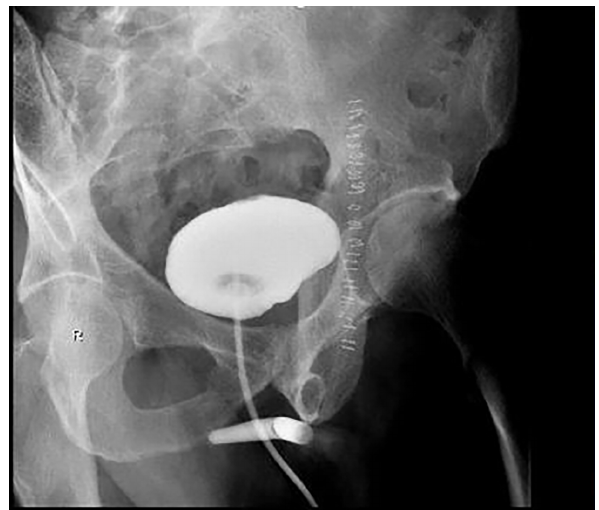
Fig. 3. A pelvic X-ray with contrast, no extravasation was no-